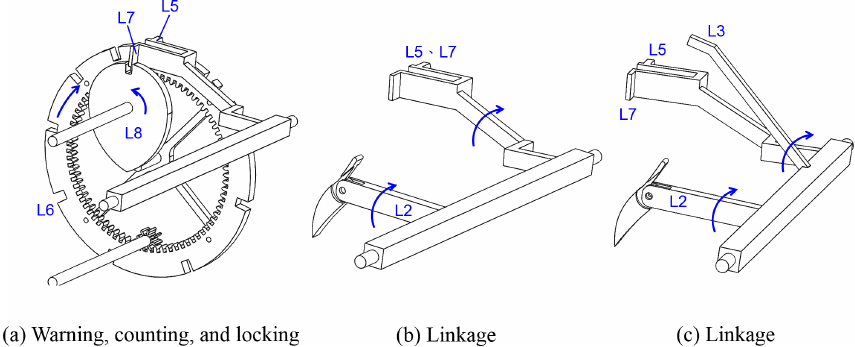
Figure 18. Structure and operation of the N6 trigger mechanism. (The trigger is similar to that of N2.)